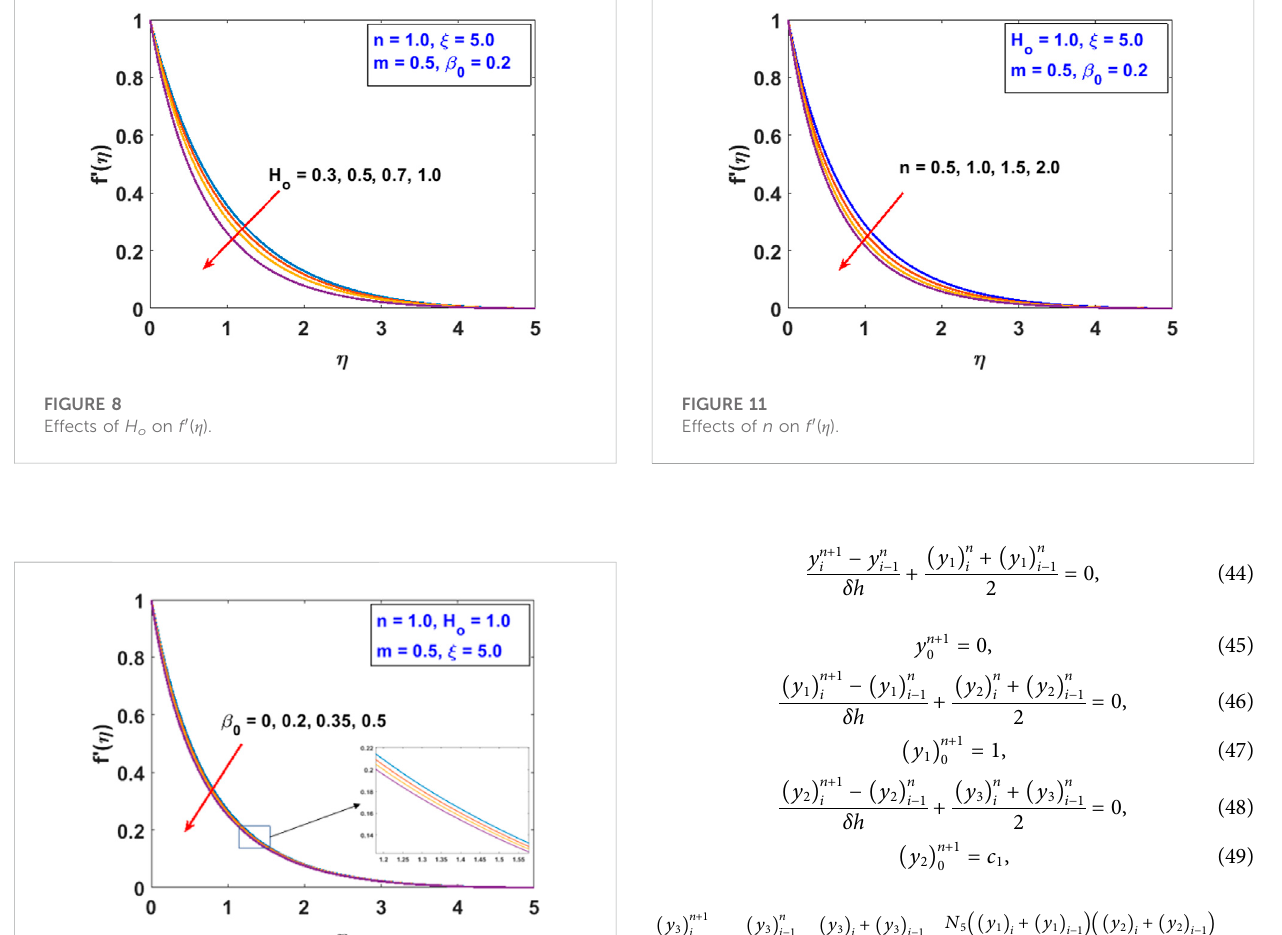
FIGURE 9 Effects of β 0 on f ′ ( η ).